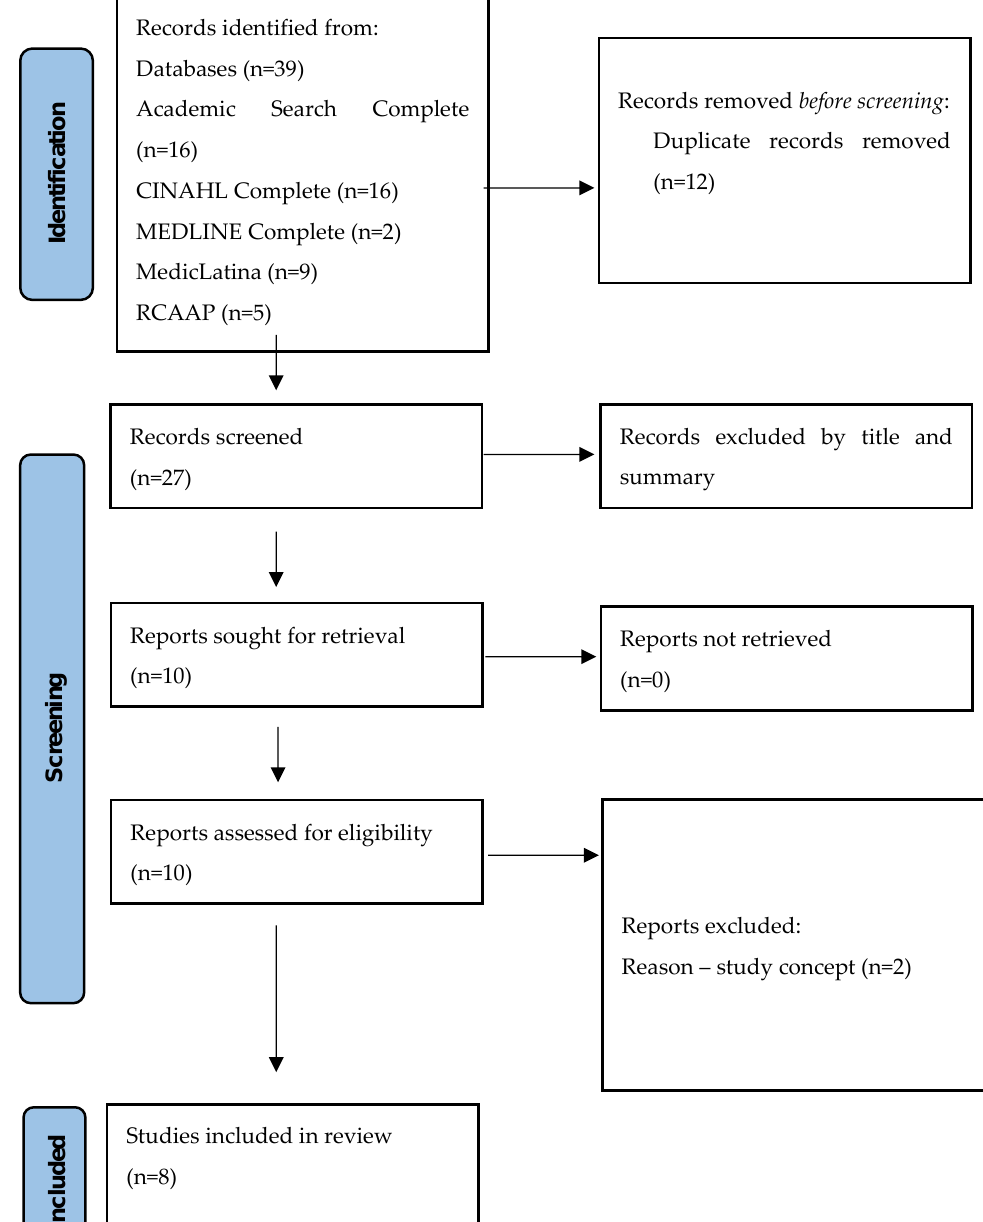
Figure 1. PRISMA flow diagram of the systematic review process